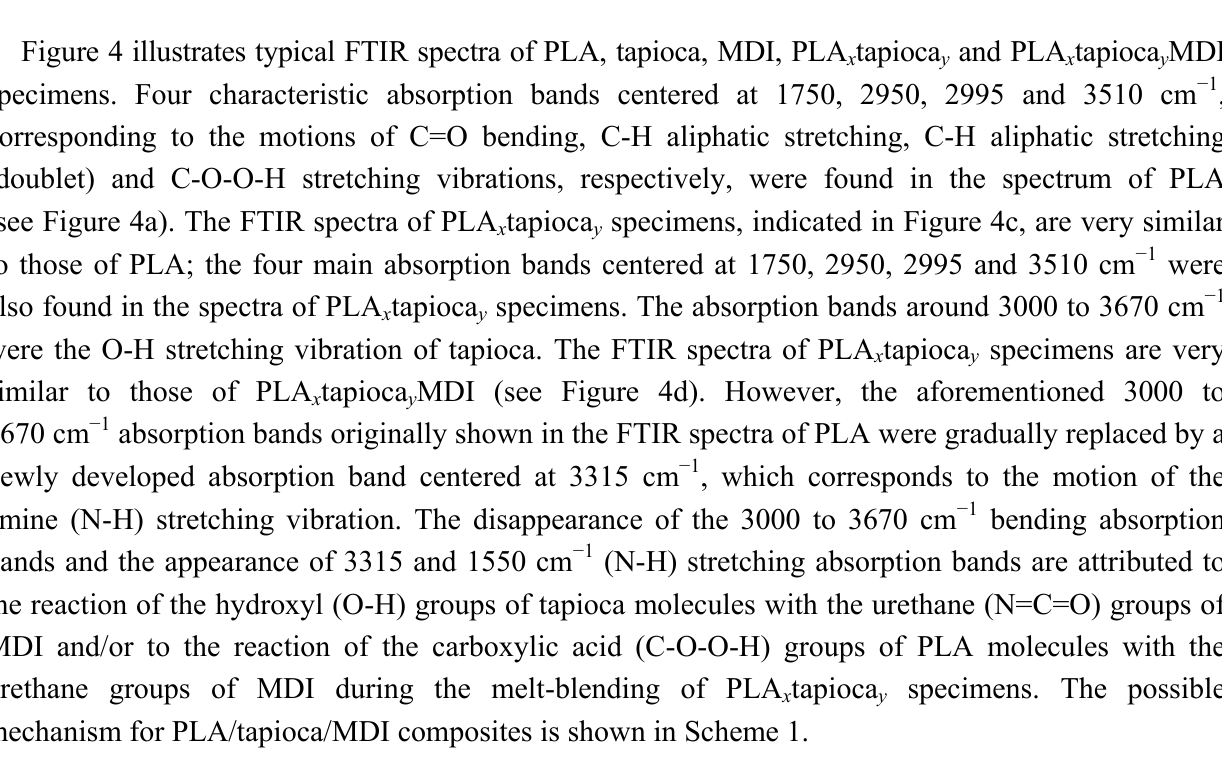
Figure 4. FTIR of: ( a ) PLA; ( b ) tapioca; ( c ) PLA/tapioca; ( d ) PLA/tapioca/MDI; and ( e )